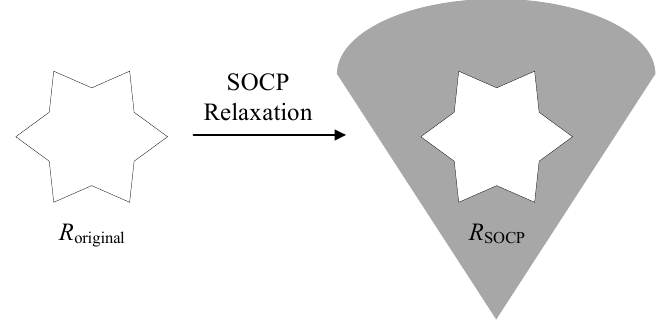
Figure 1. Schematic diagram of second-order cone programming (SOCP) relaxation.